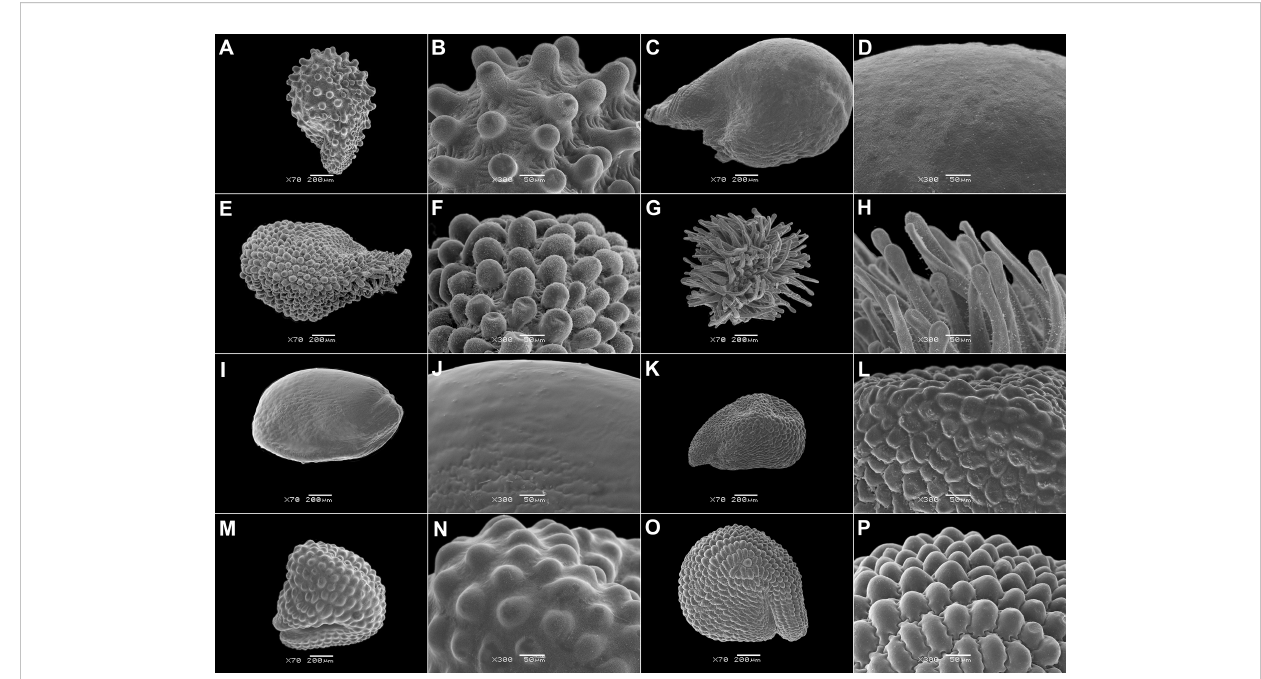
FIGURE 6 SEM micrographs of seeds of selected Ruschioideae-Ruschieae species. (A, B) Acrodon parvifolius , (C, D) Antimima ventricosa , (E, F) Astridia longifolia , (G, H) Braunsia geminata , (I, J) Carpobrotus edulis , (K, L) Cheiridopsis peculiaris , (M, N) Circandra serrata , and (O, P) Cylindrophyllum hallii . Magni fi cation: (A, C, E, G, I, K, M, O) 70×; (B, D, F, H, J, L, M, P) 300×.